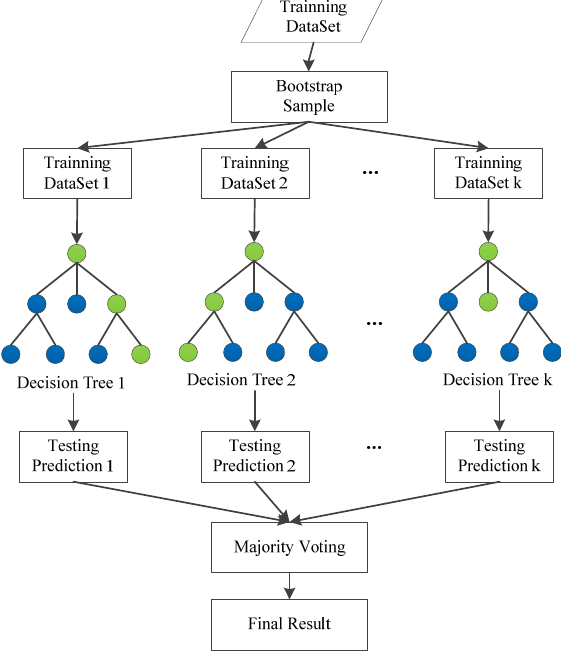
Figure 3. The principles of random forest modeling.